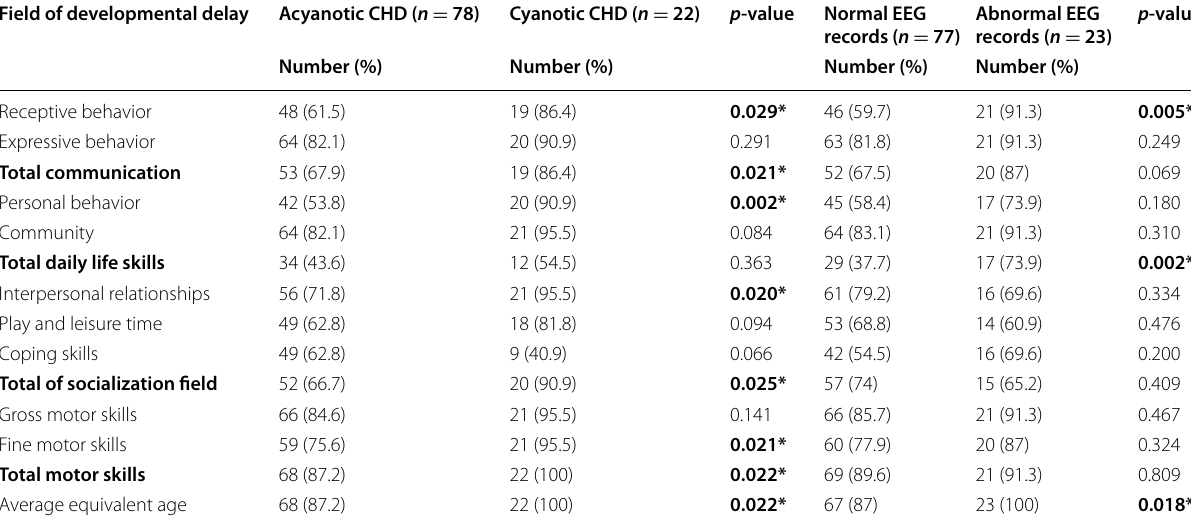
VABS Vineland Adaptive Behavior Scale, CHD Congenital heart disease, EEG Electroencephalographic *Statistically